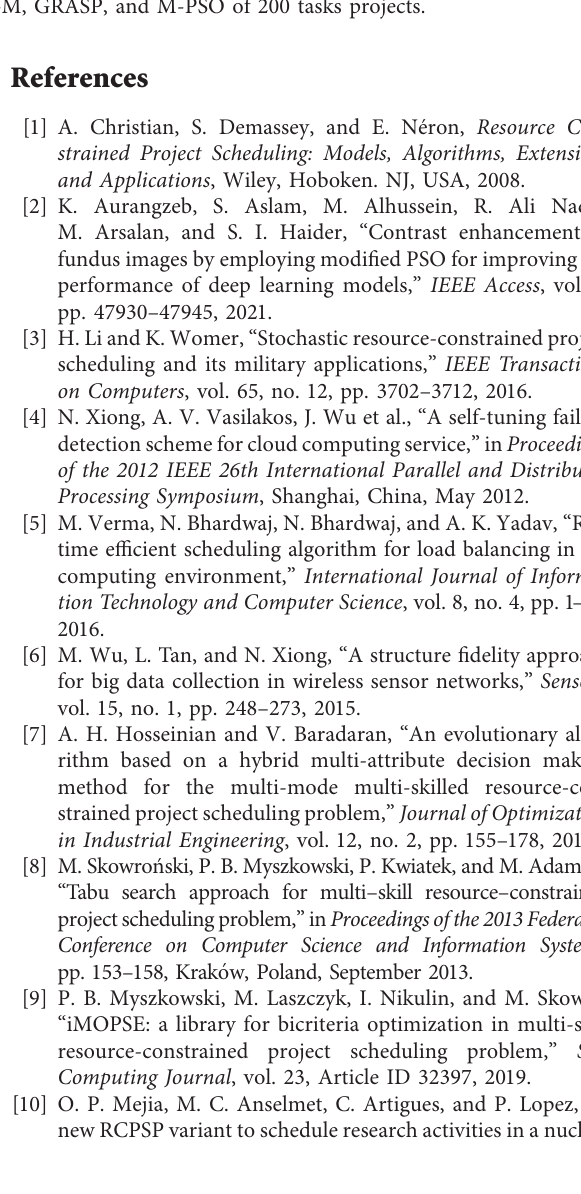
Figure 10: Comparing STD values between GA-M, GRASP, and M-PSO of 200 tasks